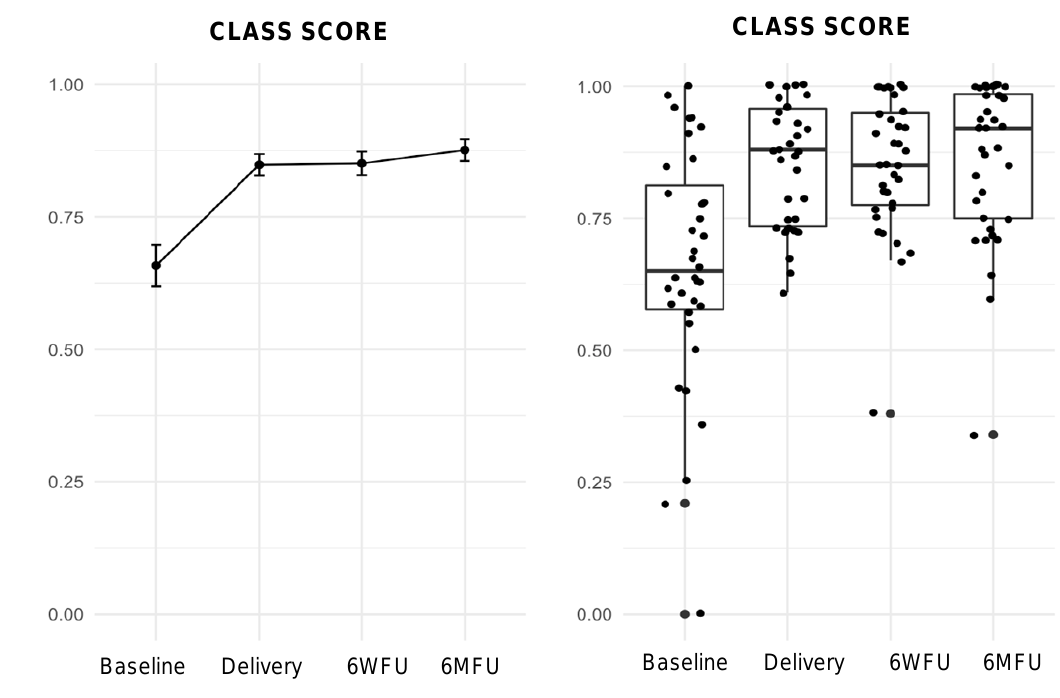
Figure 3: CLASS score at baseline (with existing socket) and at delivery of the new socket, including follow-up at 6 weeks and 6 months.